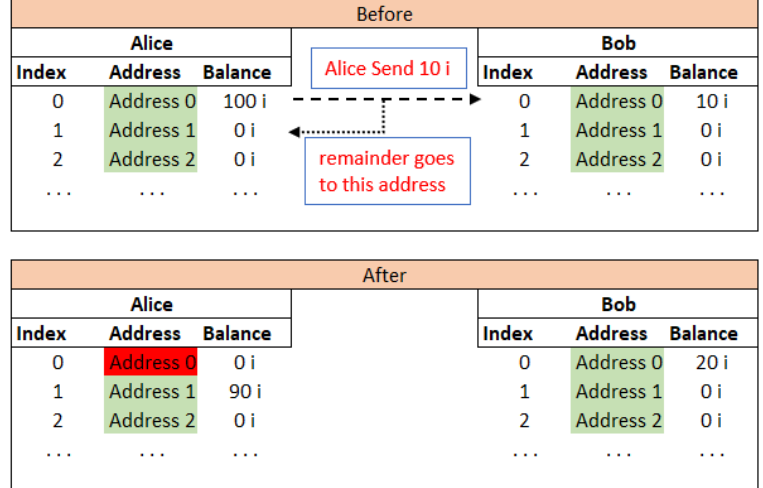
Figure 22. Problem of re-using used addresses.